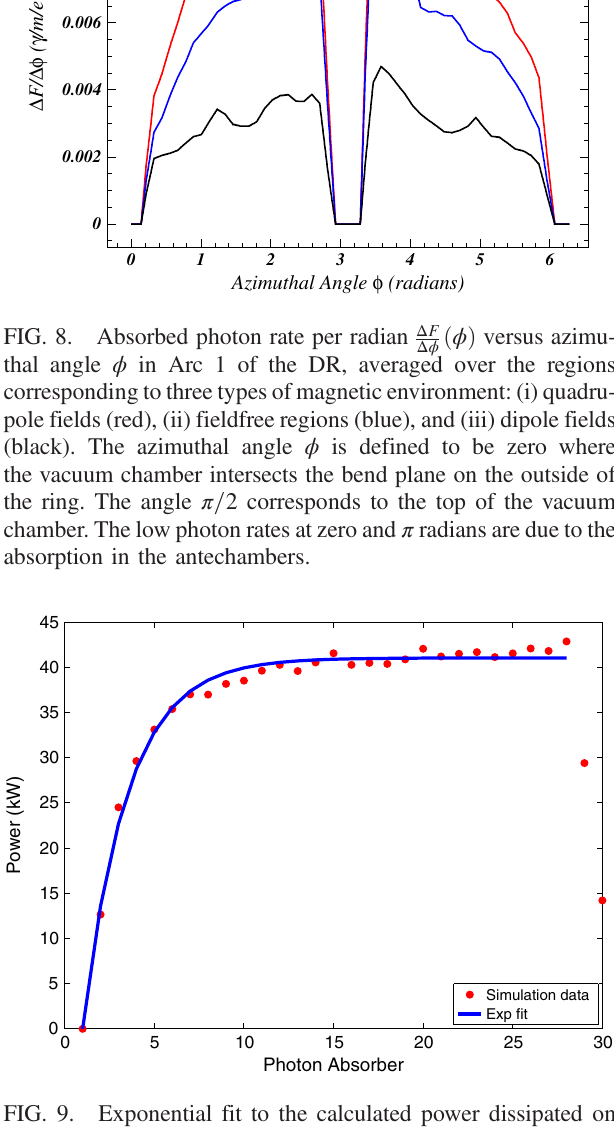
FIG. 9. Exponential fit to the calculated power dissipated on each photon absorber in the damping wiggler straight